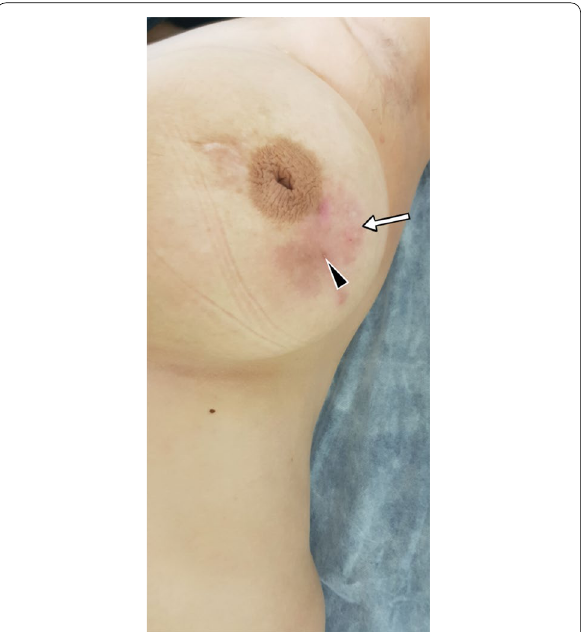
Fig. 3 A 33-year-old female patient. Erythema of the skin in the left breast (arrow) and fistula orifice